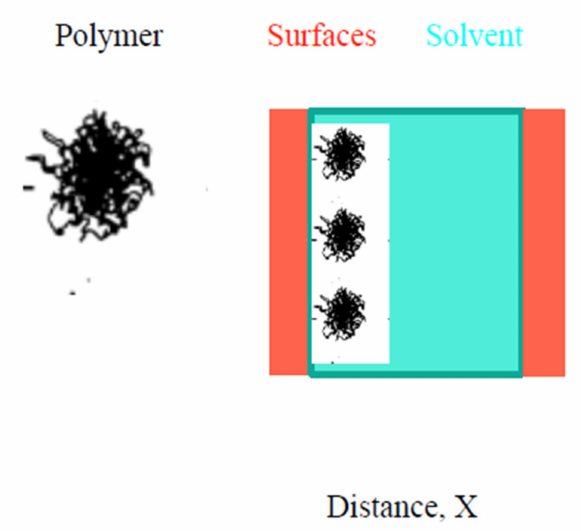
Figure 4. Covered surfaces, in red at a distance X apart with the polymer and solvent in between: polymers mix with the solvent, light blue; thus, surfaces saturate. Compression of solvated polymer films occurs, and interpenetration takes place. This is why polymer chains are not drawn in direct contact with the surface, as they should be. Each step has its own energy contribution, and the final stabilization is the sum of these terms. The distance among surfaces is, by definition, much higher than the polymer